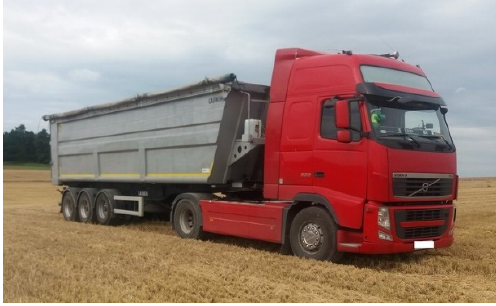
Figure 1. Semi-trailer truck Volvo FH13.